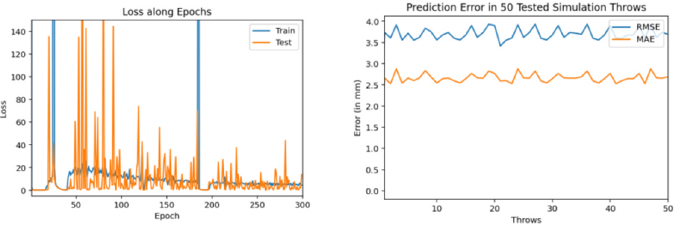
Figure 14. Training and testing results by encoder-decoder bidirectional LSTM deep NN (trained through 3000 throws with 300 epochs and 200 neurons).